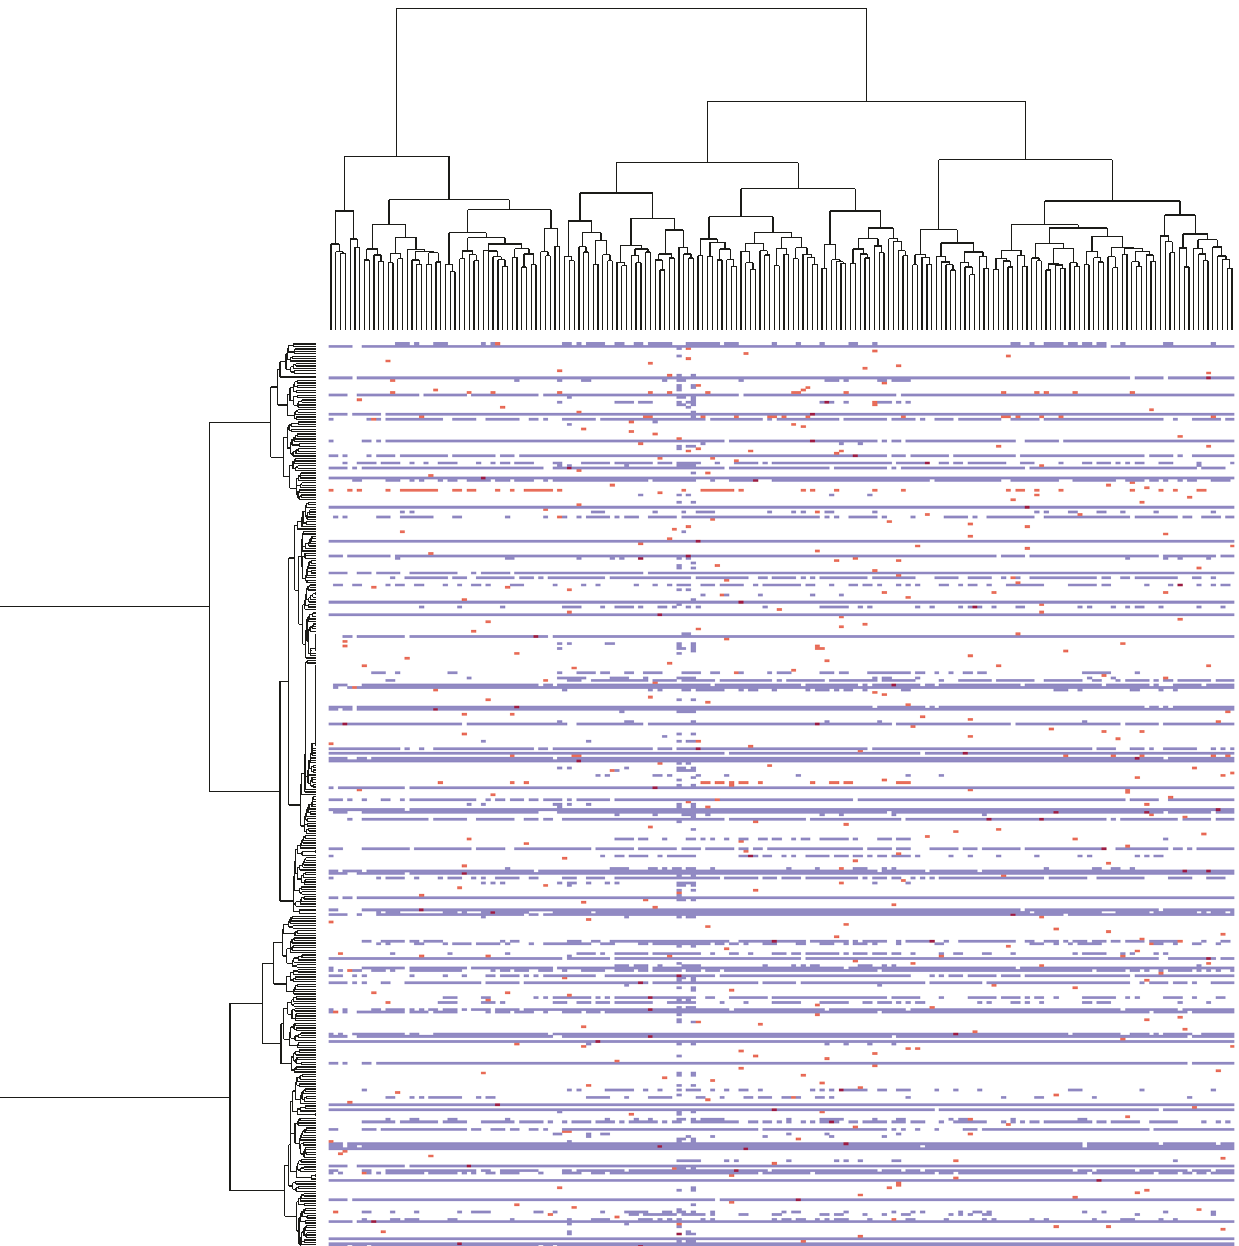
Figure 8: Pattern recognition after combination of methylation and mutation. x -axis represents the number of patients ( n = 200 ), and y -axis represents the number of the most hypermethylated genes ( n = 879 ). Dendrogram represents three clusters of AML patients and four clusters of the most hypermethylated